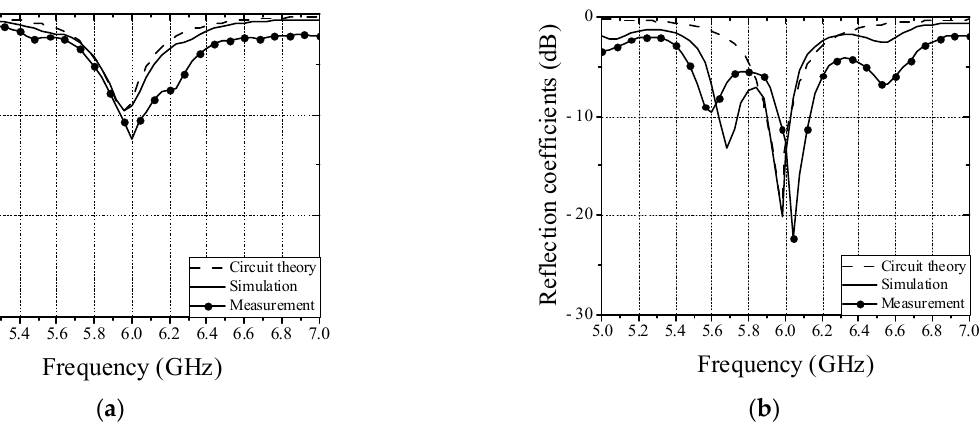
Figure 3. Comparison of reflection coefficients among equivalent circuit model, full-wave simulation, and measurement. ( a ) Non-defect wire. ( b ) Defective wire.